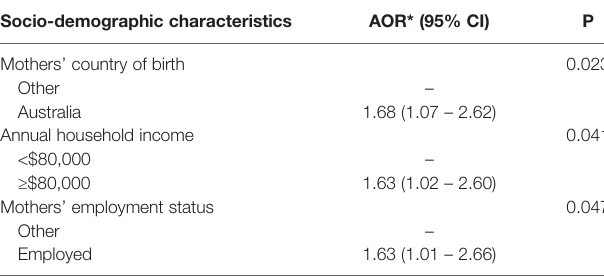
TABLE 3 | Associations of participant socio-demographic characteristics with engagement in telephone support program using ordinal logistic regression. Socio-demographic characteristics